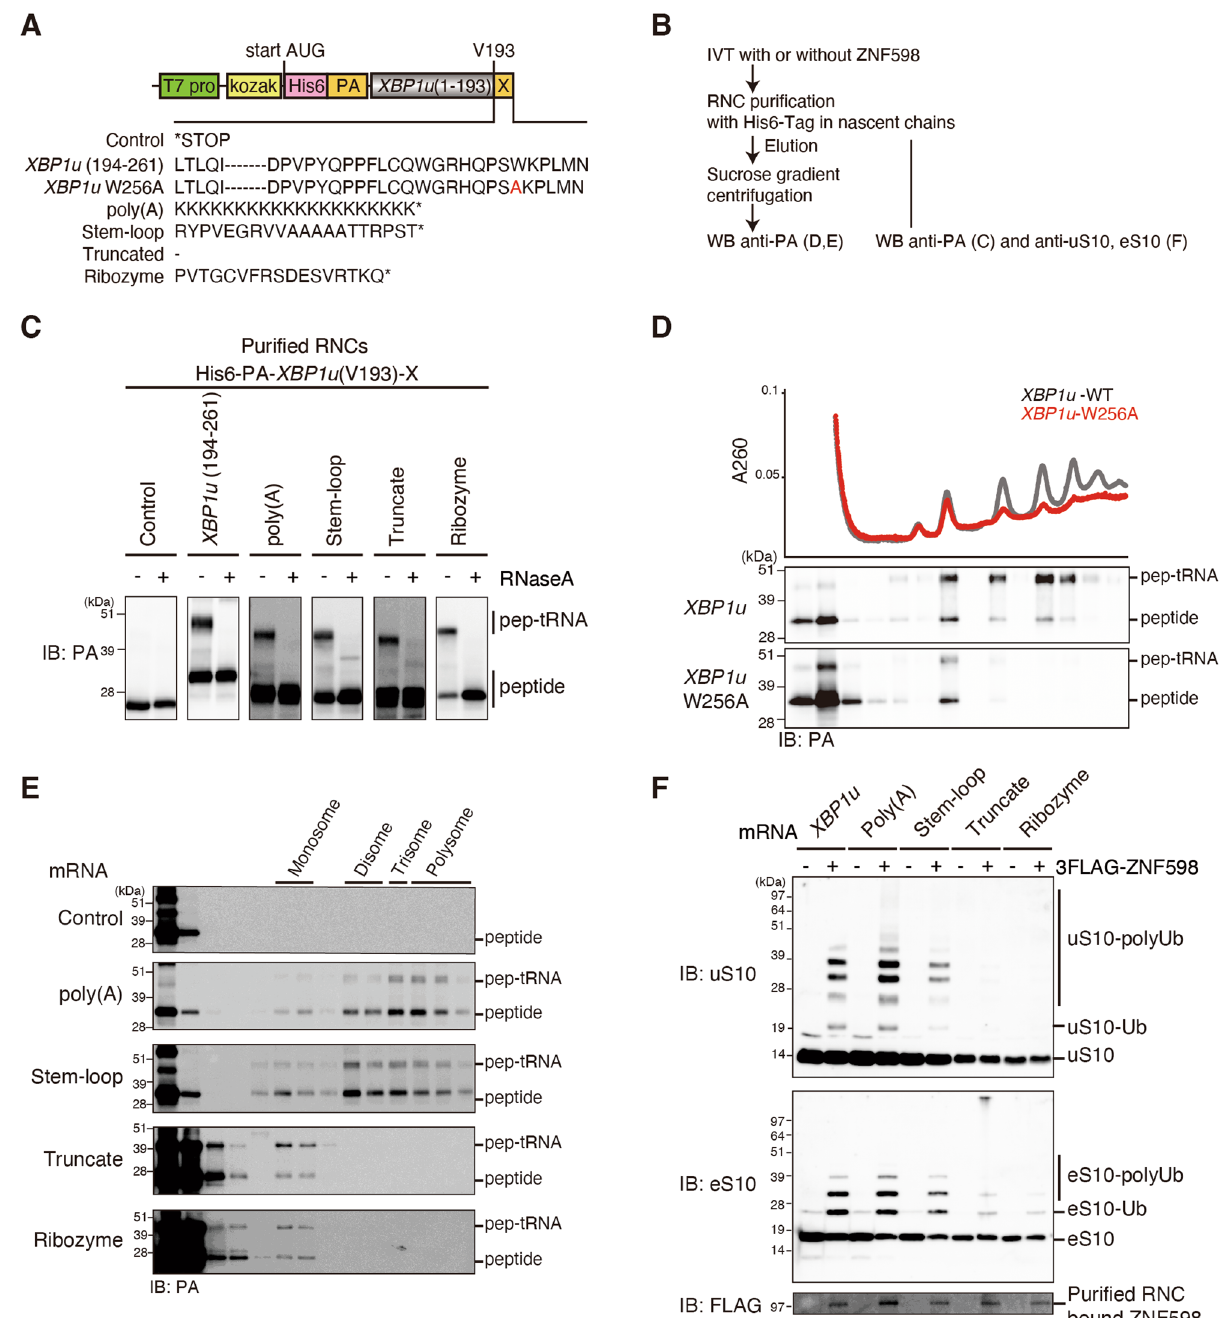
Fig. 1 | In vitro reconstitution of translational arrest and ZNF598-mediated ubiquitination. A Schematic representation of mRNA templates used in RRL in vitro translation reactions. All constructs encode the N-terminal part of XBP1u (1 – 193), which is appended (X) by either the XBP1u (194 – 261) stalling sequence, a poly(A) stretch, a stable RNA stem-loop sequence or a self-cleaving ribozyme (Rz). All constructs contain an N-terminal His 6 and PA-tag for af fi nity puri fi cation and antibodydetection. B Schematicoverviewoftheinvitrostallingandubiquitination assays. C – E In vitro translation of staller mRNAs from A . The free peptide and the peptidyl-tRNA(pep-tRNA)arrestproductsweredetectedbyWesternblottingusing an anti-PA antibody. We obtained essentially the same results as two independent